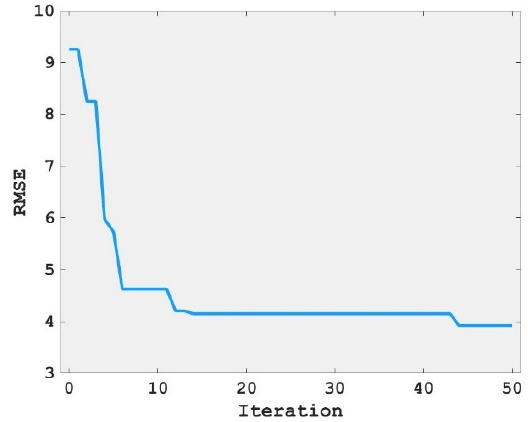
Figure 5. Relationship between the iteration and RSME value.